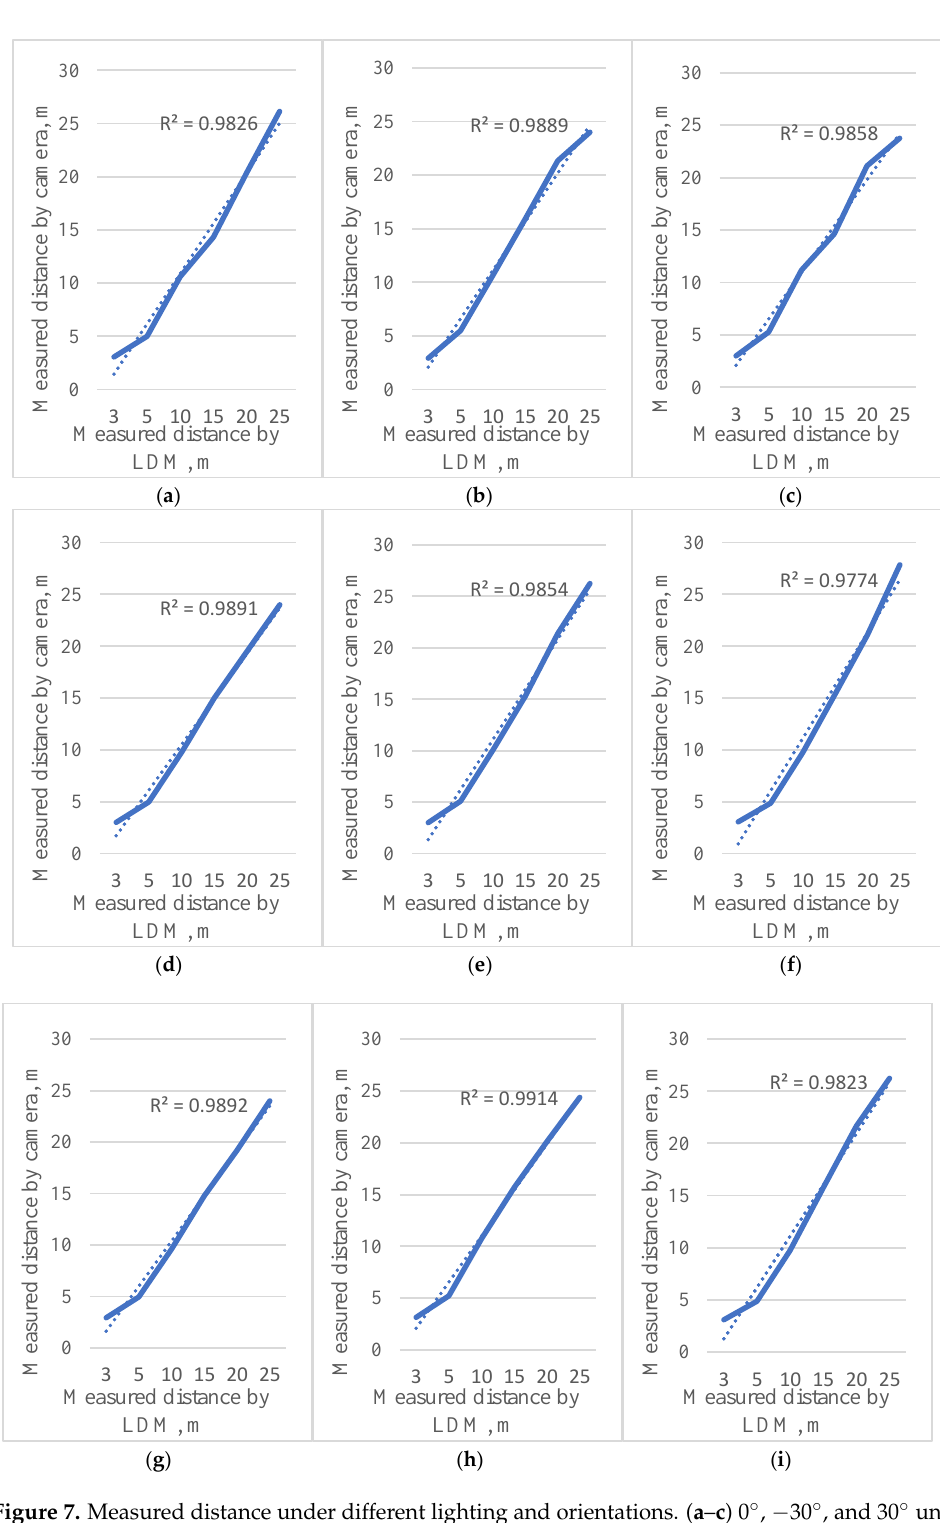
Figure 8. Measurement errors of target objects from a distance of 0 to 25 m under different lighting conditions and orientations of the thermal camera. 3.2. Model Training and Validation The number of iterations were 40,000 (the training times are shown in Table 2), and the losses were reported as total loss, bounding box loss, classification loss, regional pro- posal network (RPN) classification loss, and RPN bounding box loss (Figure 9). According to Figure 9, the total loss function dropped to approximately 0.6 and oscillated near 0.6 when training reached 40,000 iterations, effectively reaching convergence. In addition, both the bounding box loss and classification loss converged; thus, training was stopped at 40,000 iterations. However, the results showed that the converged losses did not reach below 0.1, while other studies had less than 0.1 [40]; these results likely occurred because the two types of trees (conventional and joint) were investigated in this study, which dif- fered markedly in shape. In addition, in the conventional orchard, the trees differed mark- edly in size, with some trees being 30 cm wide and some less than 5 cm, which led to a larger loss convergence result. In addition, randomly selected images were used to pre- pare the validation set. There were original images and randomly flipped and rotated im- ages under the three lighting conditions (Figure 10). Compared with YOLOv3 using the